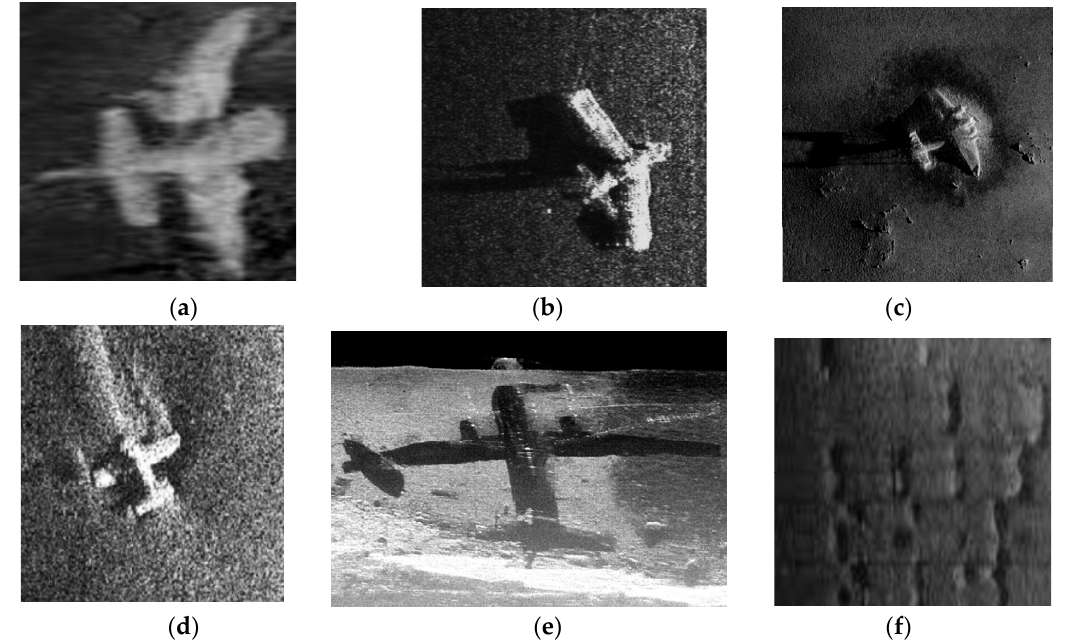
Figure 12. ( a ) Aircraft with fuzzy features. ( b – d ) Aircraft with smaller target object. ( e ) Aircraft with missing tail. ( f ) Pure seabed